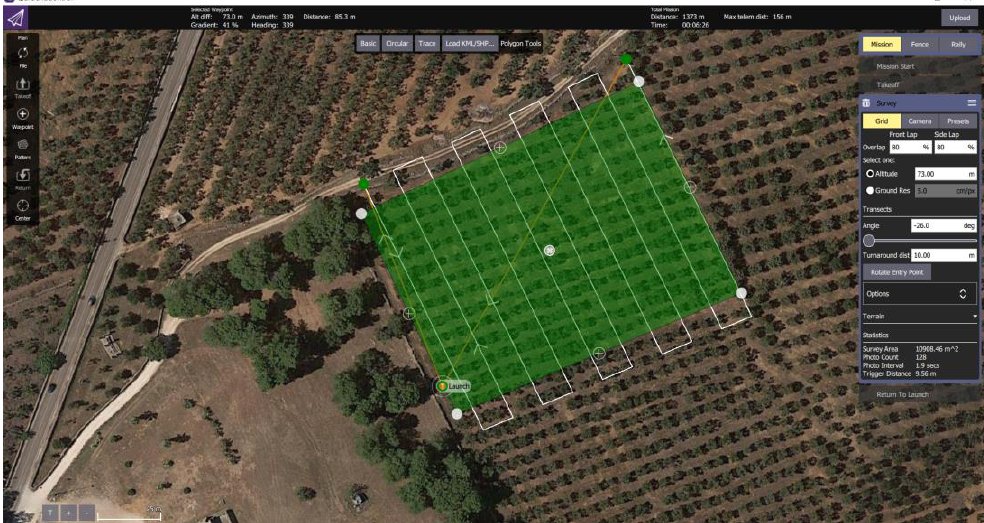
Figure 3. Example of one aerial survey plan for an olive orchard (Squinzano-Cerrate, 40°27'35.79"N, 18° 7'2.69"E).